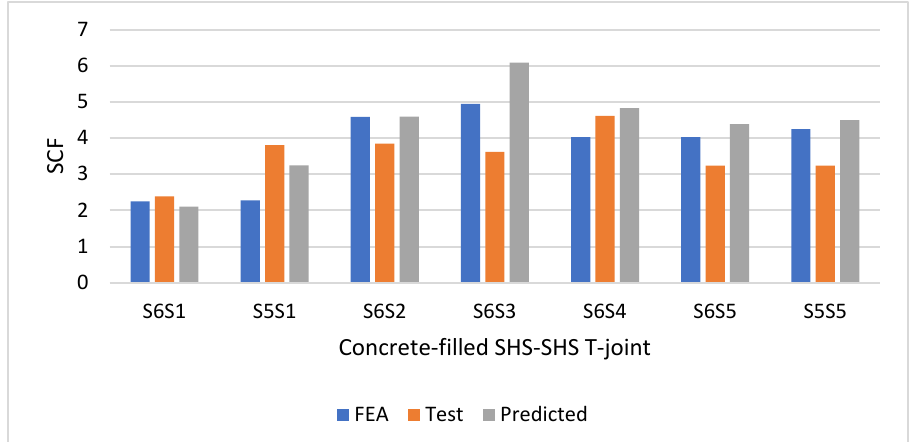
Figure 15. Comparison of SCFs from the FEA, test, and predicted design equations.